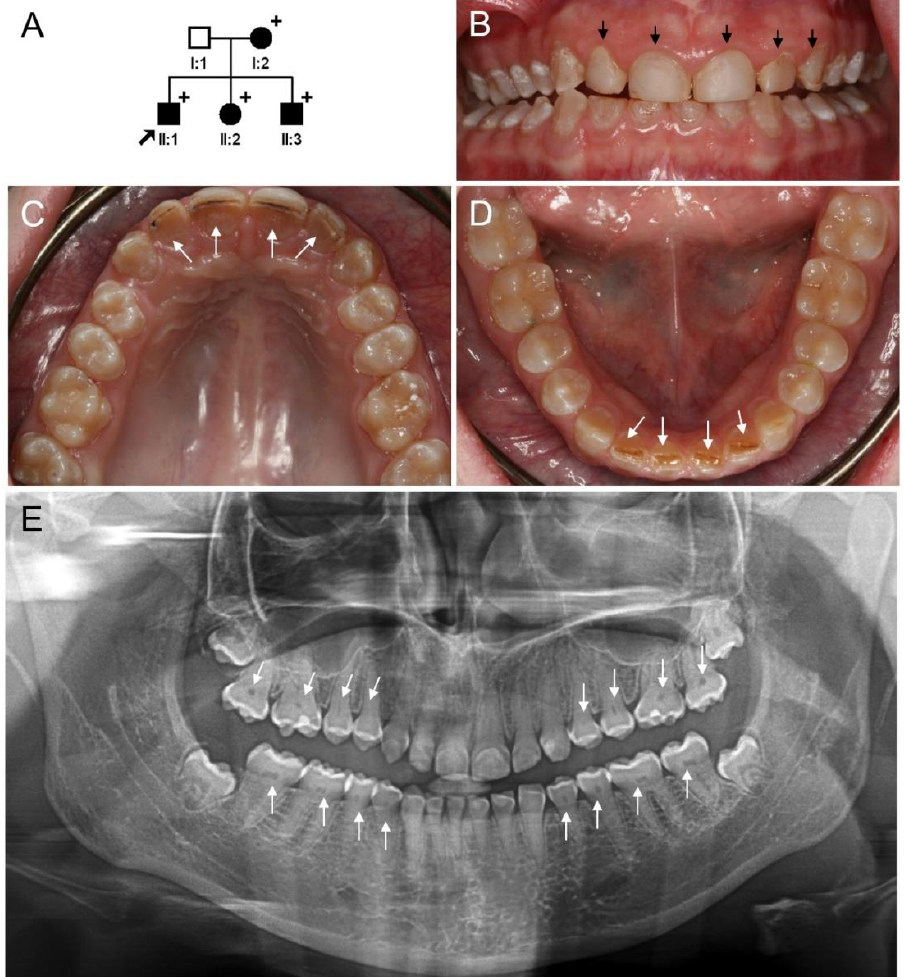
Figure 3. Pedigree, clinical photos, and panoramic radiograph of family 3. ( A ) Pedigree of family 3. Black symbols indicate affected individuals and the proband is indicated by a black arrow. Plus signs above the symbols indicate participating individuals. ( B – D ) Clinical photos of the proband (II:1) at age 18. Mild discoloration can be seen in the anterior teeth. Labial surfaces of the maxillary anterior teeth have been restored with resin composite (black arrows). Increased attrition and dentin exposure can be seen in the maxillary and mandibular incisors (white arrows). Posterior teeth are normal without discoloration and attrition. ( E ) Panoramic radiograph of the proband at age 18 years shows partial pulpal obliterations resembling thistle-tube-shaped pulp chambers (white